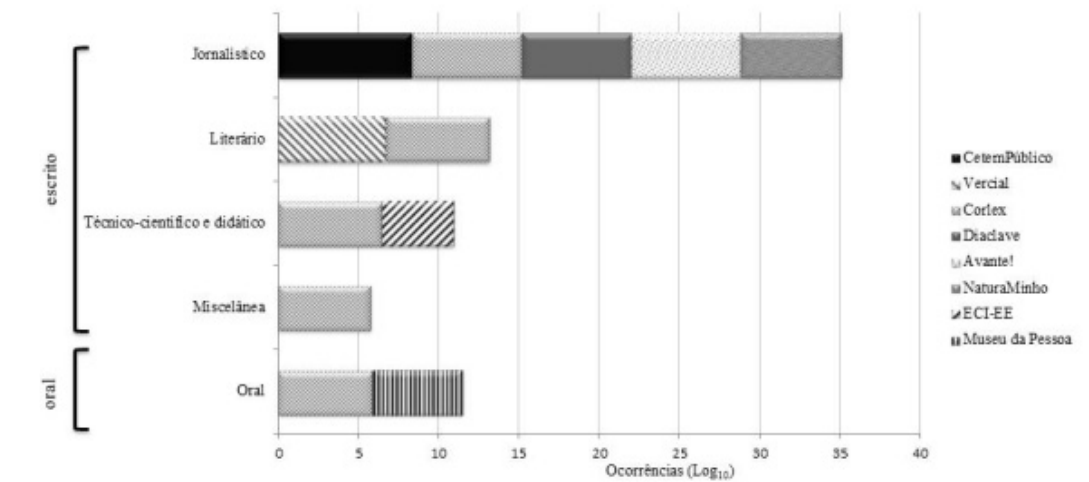
Figura 1 . Distribuição dos corpora do P-PAL por género e tipo